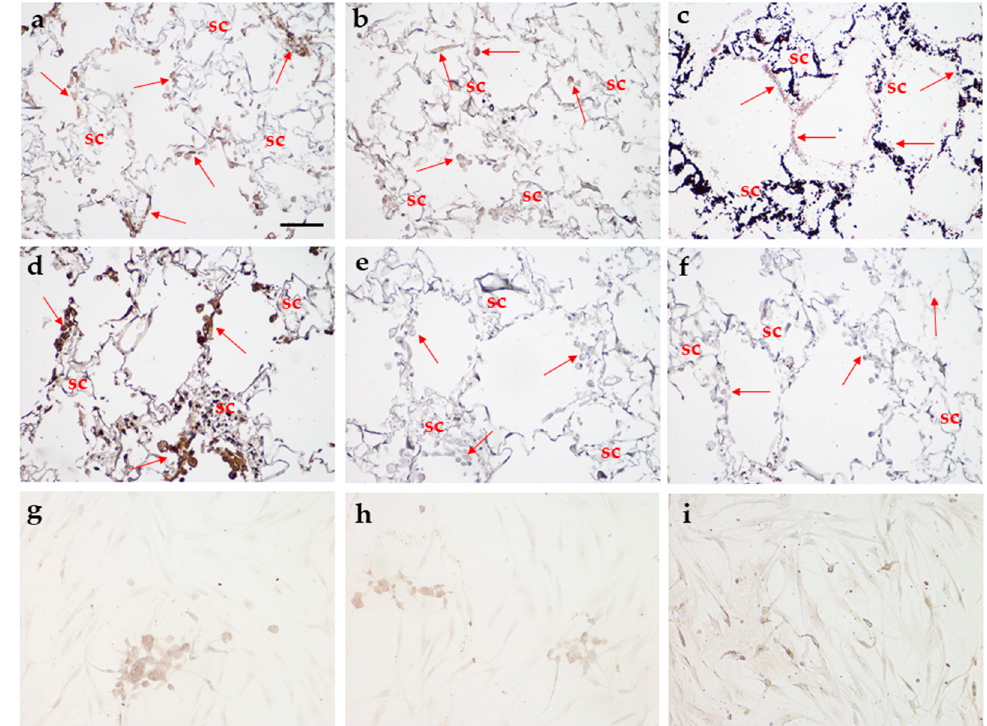
Figure 5. Histological analysis of the 3D osteogenic model and MPCs endothelial differentiation in 2D culture. ( a – f ) Osteogenic model: ( a ) IHC analysis for ALP; ( b ) IHC analysis for Osteocalcin; ( c ) von Kossa staining: mineralized matrix in black, cell nuclei in red; ( d ) IHC analysis for Flk-1; ( e ) IHC analysis for p-Flk-1; ( f ) IHC analysis for PECAM-1. ( g – i ) Endothelial differentiation of MPCs in 2D model: IHC analysis for: ( g ) Flk-1, ( h ) p-Flk-1, ( i ) PECAM-1. SEM analysis. Antigen expression is revealed in brown, cell nuclei are in blue-violet. Sc = scaffold; red arrows = cells. Scale bar = 100 μ m. Original magnification 200×.